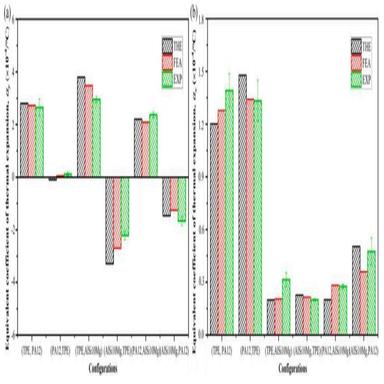
Theoretical, numerical and experimental results of (a) αy and (b) αx of the six kinds of bimaterial 3D DVH lattices.